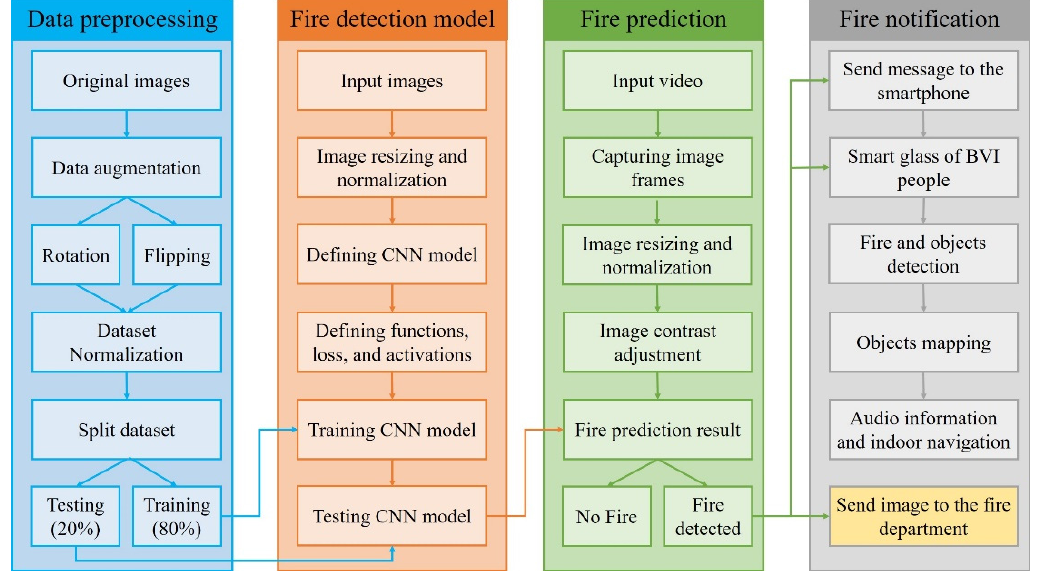
Figure 4. Block diagram of the proposed system.